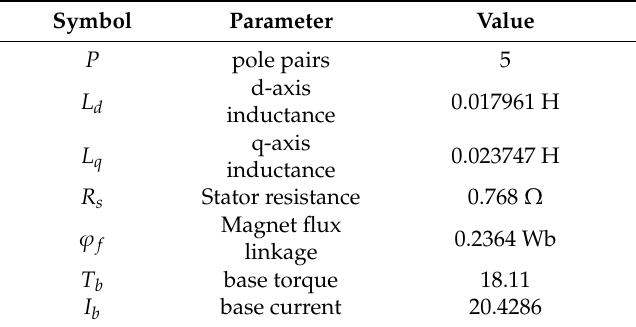
Table 1. Parameters of